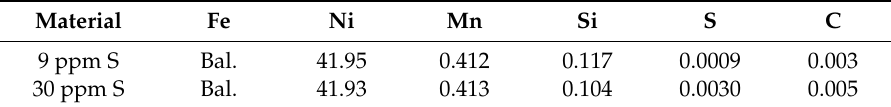
Table 1. The composition of the two materials used in this study. All the data are given in wt.%. Iron (Fe), nickel (Ni), manganese (Mn) and silicon (Si) contents were obtained from X ‐ ray fluorescence and sulphur (S) and carbon (C) contents from glow discharge mass spectrometry (GDMS).